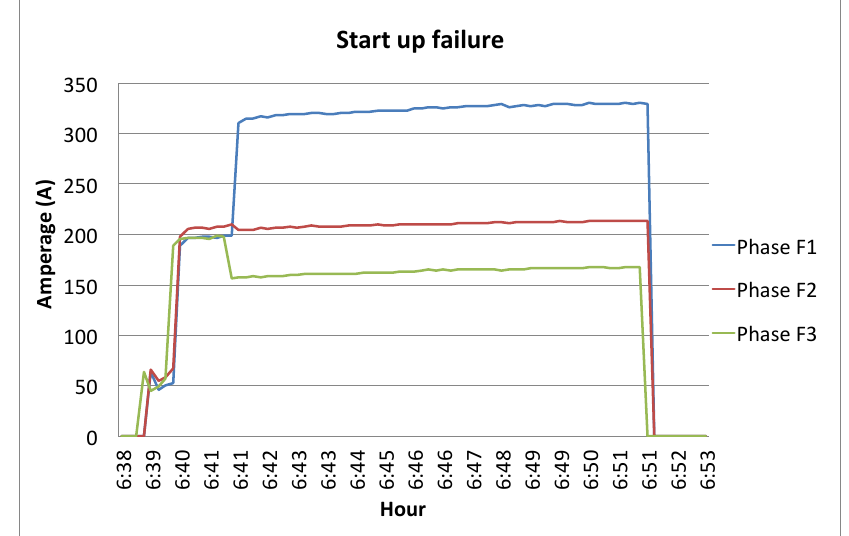
Figure 5. Trend of energy absorption of the old motor during breakdown.